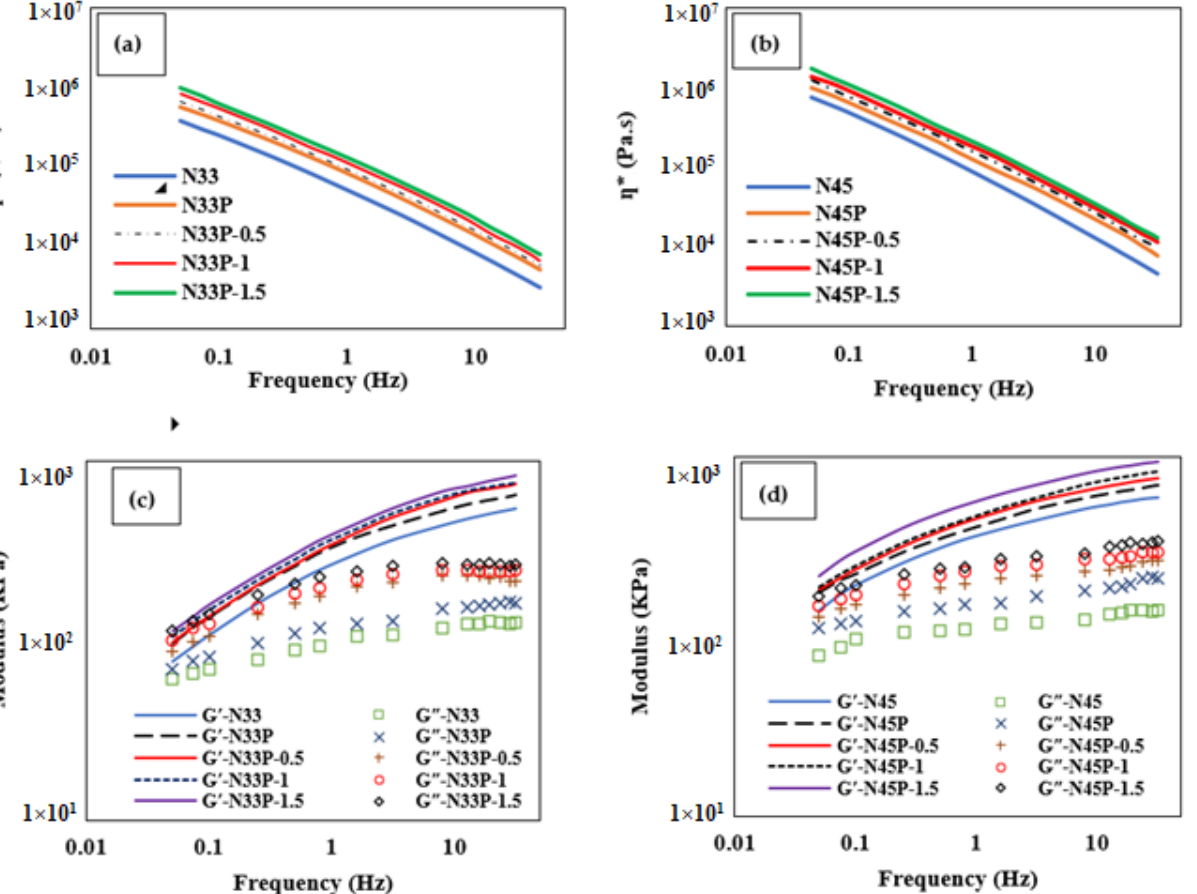
Figure 4. ( a , b ) Complex viscosity ( ŋ *) vs. the frequency changes; ( c , d ) Variations in the storage modulus ( G′ ) and the loss modulus ( G″ ) with frequency at 50 °C between 0.05 and 30 Hz with 7% strain.